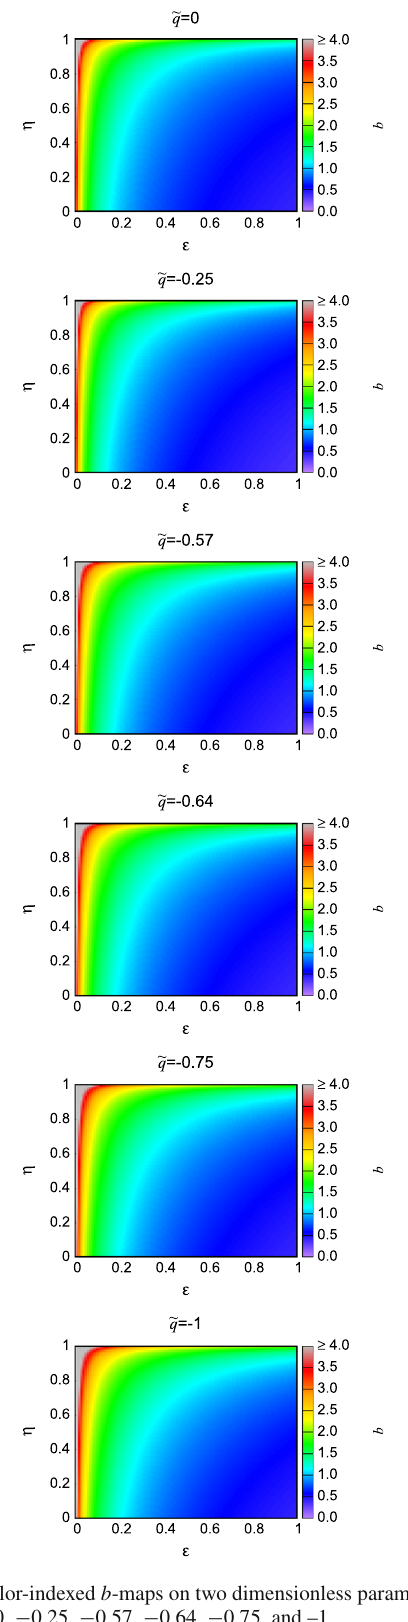
Fig. 6 Color-indexed b -maps on two dimensionless parameters (cid:15) and η for ˜ q = 0, − 0.25, − 0.57, − 0.64, − 0.75, and